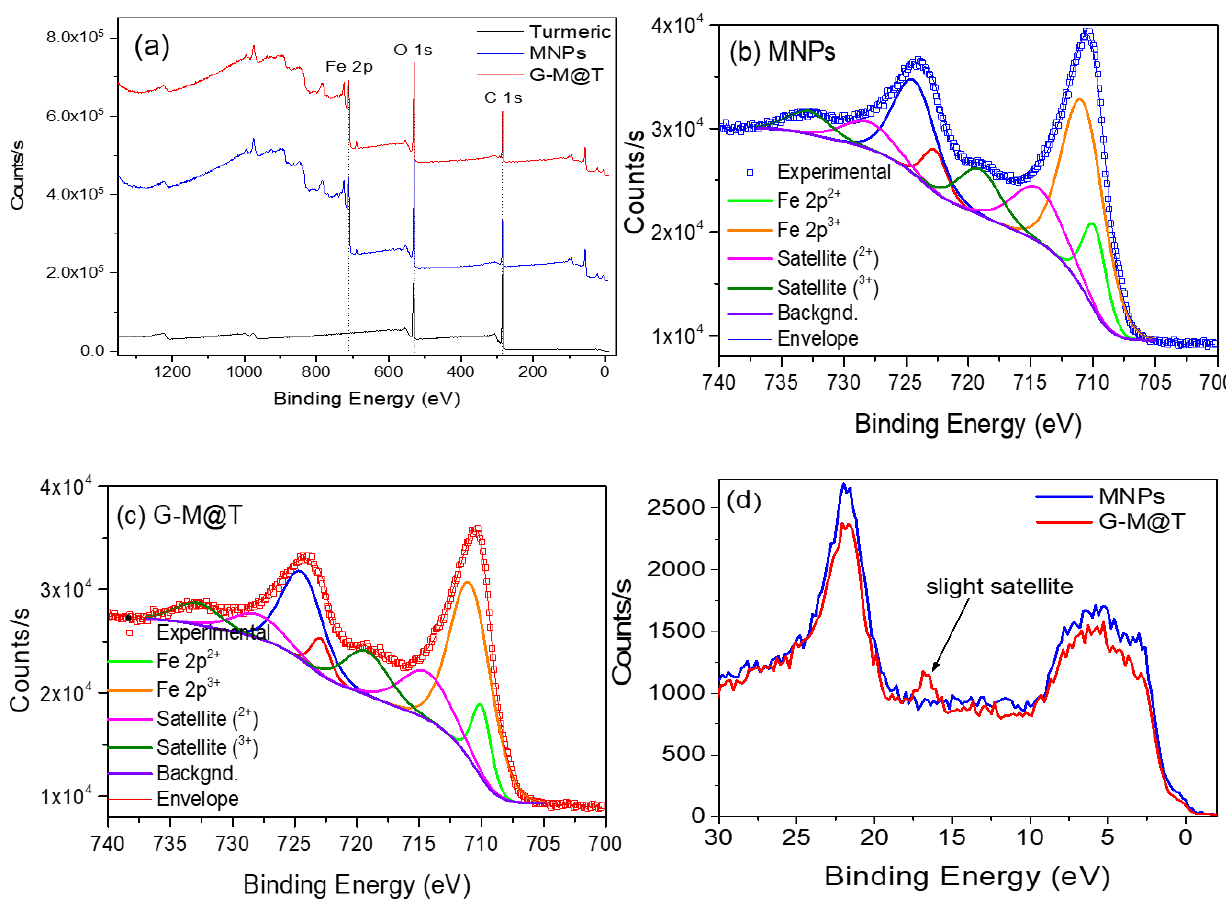
Figure 3. ( a ) XPS survey spectra for turmeric powder, MNPs, and G-M@T samples. XPS core-level spectra of Fe 2p doublets for ( b ) MNPs and ( c ) G-M@T samples. ( d ) XPS valence band spectra of MNPs and G-M@T samples.